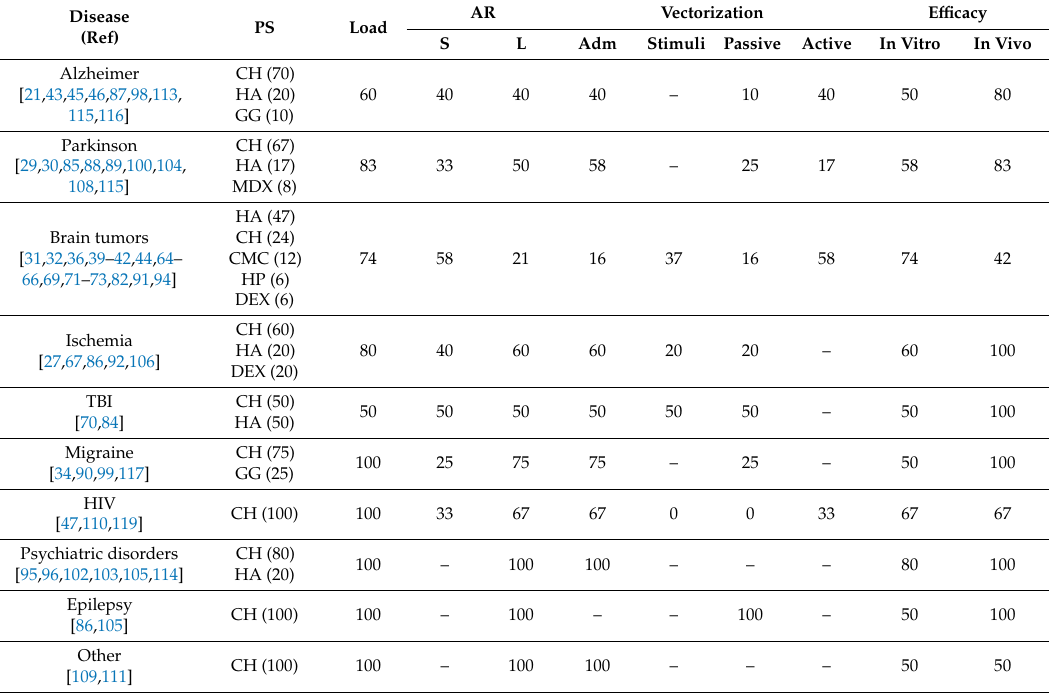
Table 4. Outcomes of PSC proposed for the treatment of brain diseases reviewed in this paper. Percentages are based on the total studies of each disease